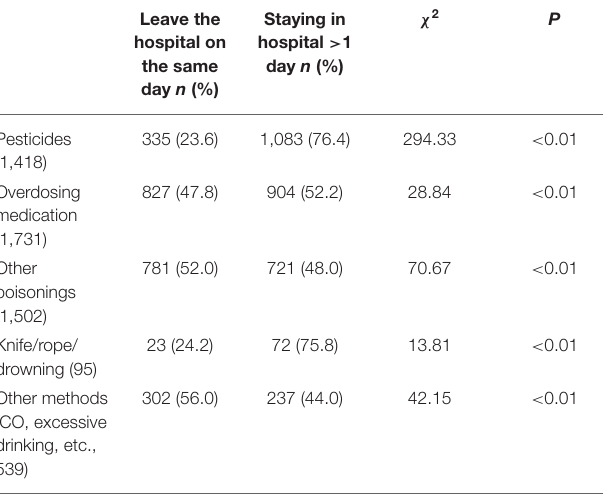
TABLE 2 | Duration of being treated in the hospital for various suicide methods. Leave the hospital